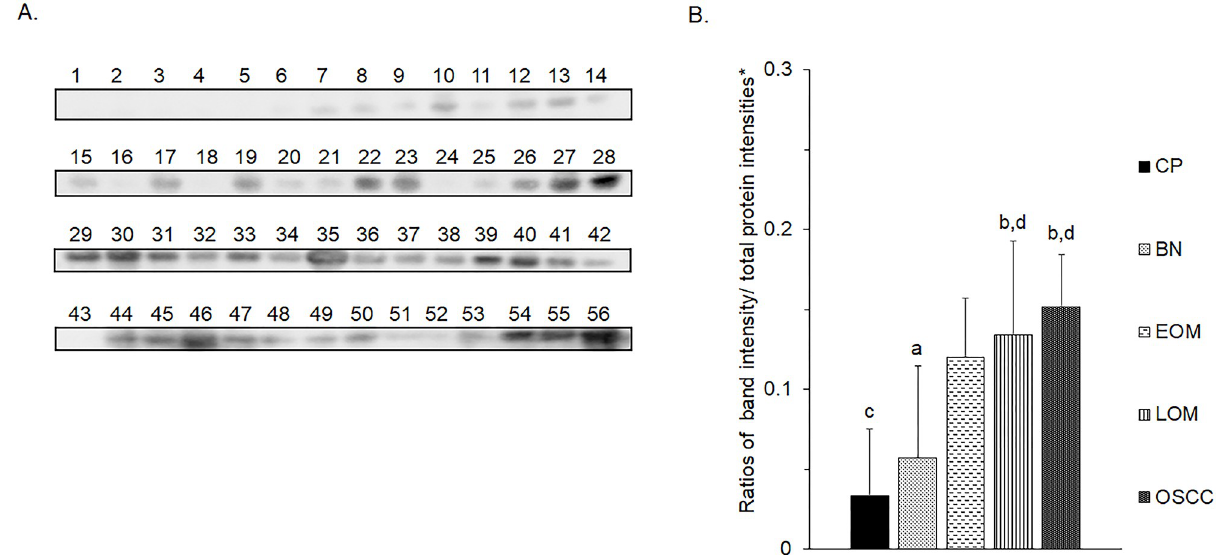
Fig 12. Western blot analysis of salivary sentrin-specific protease 7 (SENP7) of individual saliva samples from dogs with periodontitis and normal controls (CP), benign oral tumors (BN), early- and late-stage oral melanoma (EOM and LOM, respectively) and oral squamous cell carcinoma (OSCC). Representative western blot for SENP7 at 37 kDa (A) and bar graph of ratios of SENP7 protein intensity to total blotted protein intensities in each lane in the second half of a membrane � (B) . a–b and c-d denote a significant difference at p < 0.05 and p < 0.01, respectively.